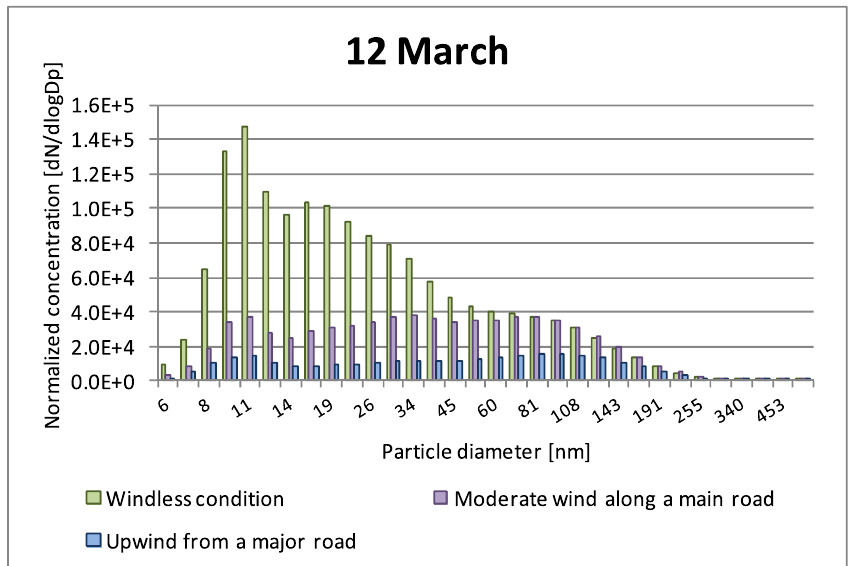
Figure 8. Particle number distribution within changing meteorological conditions in Sporilov on 12 March. Within windless condition a particle number distribution showed similar patter as measured on other days (20 February and 26 March; Figure 3) close